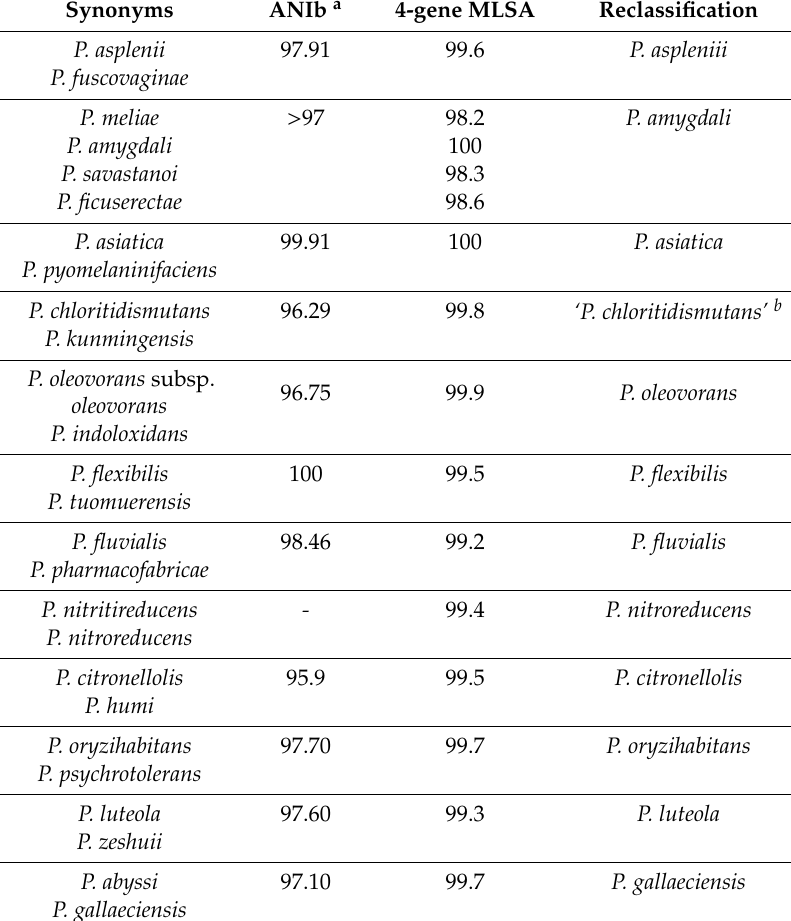
Table 1. List of Pseudomonas species currently accepted in taxonomy that should be considered synonyms after a phylogenetic analysis and their reclassification. ANIb values are the averages of the bidirectional